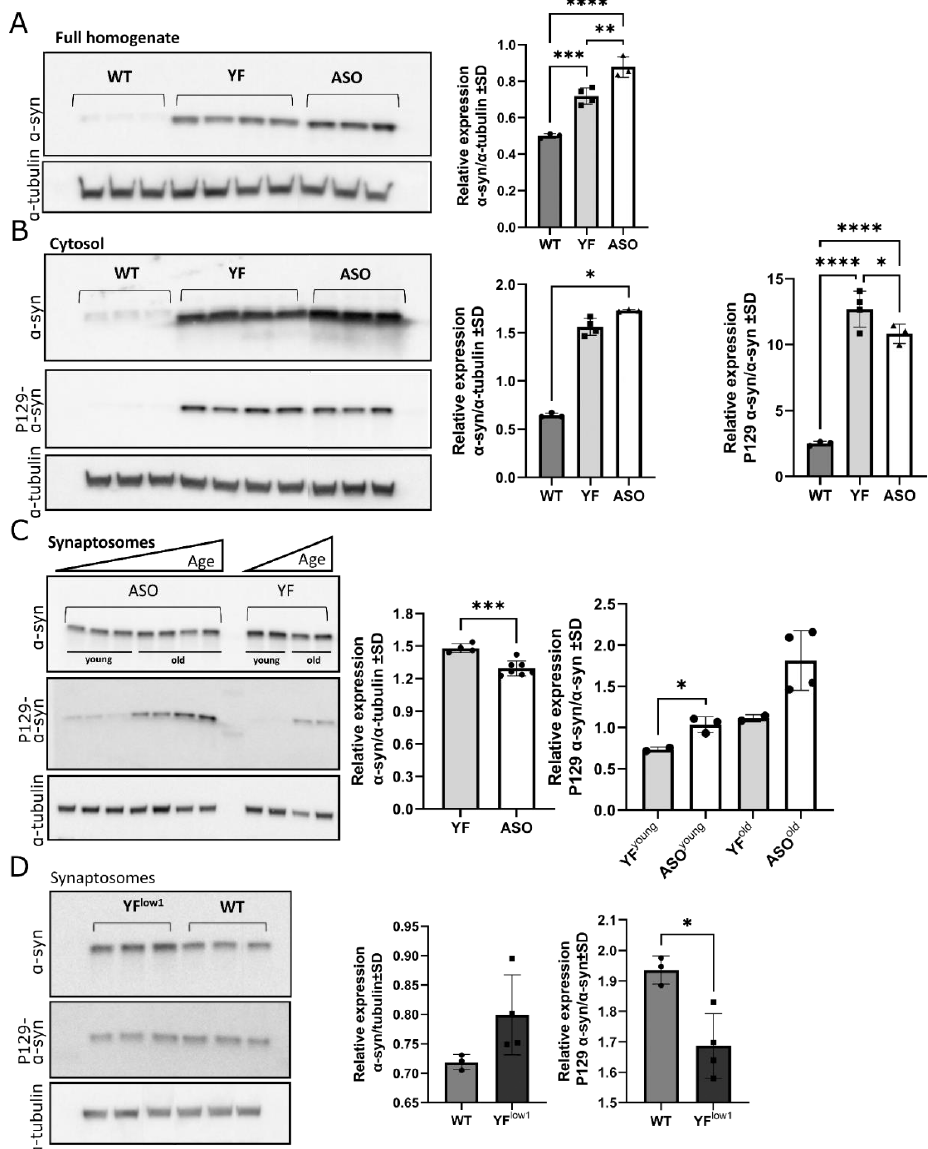
Figure 3. Biochemical determination of P129 phosphorylation of α -synuclein ( α -syn) in wildtype (WT), YF, and ASO mice. ( A ). Expression of α -synuclein and α -tubulin in whole brain homogenates ( left ) and the quantification of α -synuclein relative to α -tubulin ( right ). The YF mice ( n = 4) express significantly more α -synuclein compared to WT ( n = 3) and less when compared to the ASO mice ( n = 3). ( B ). Expression of α -synuclein, P129 α -synuclein, and α -tubulin in the soluble part of the